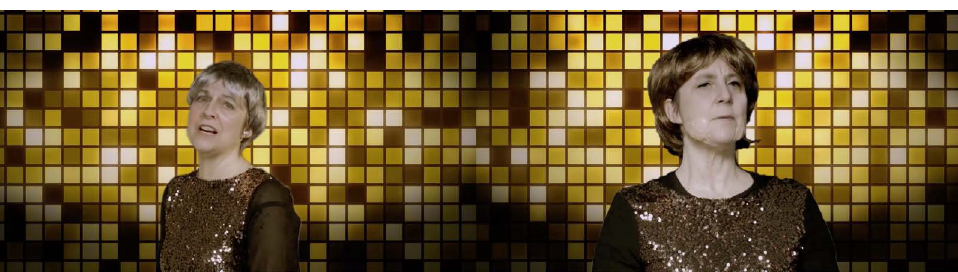
Figure 5: Libby Heaney, Euro(re)vision (2019).